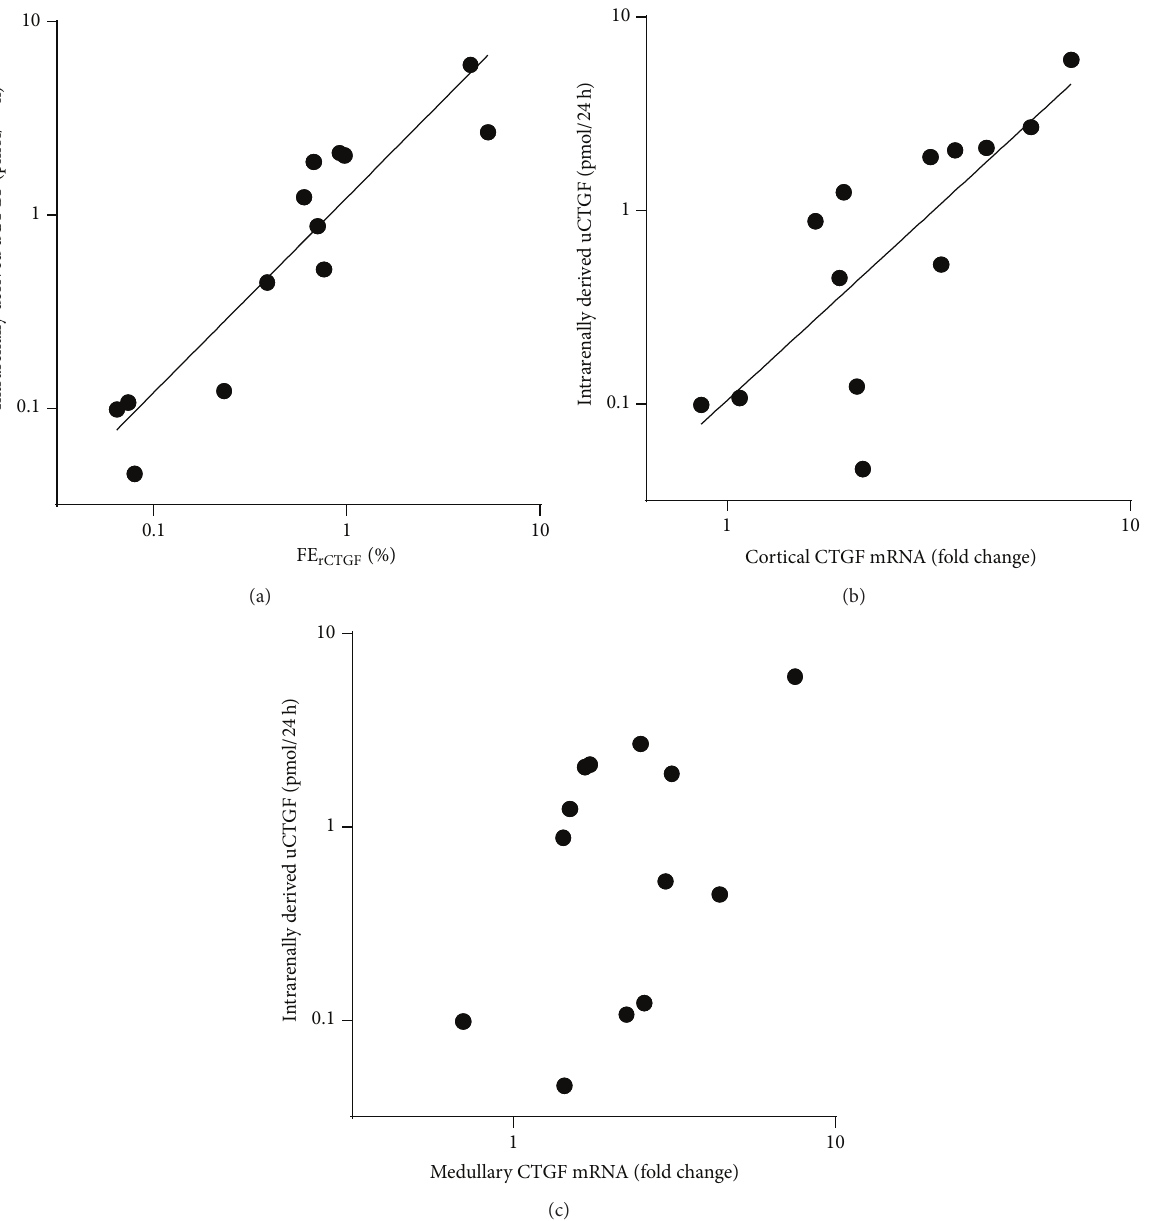
Figure 4: Urinary excretion of intrarenally produced CTGF correlates with the degree of tubular dysfunction. (a) Tight linear correlation between intrarenally derived uCTGF and FE rCTGF ( 𝑟 = 0.92 , 𝑃 < 0.0001 , slope = 1.0±0.1 ) suggests that tubular reabsorption failure is a major determinant of intrarenally derived uCTGF. (b) Cortical CTGF mRNA levels correlate with the intrarenally derived urinary CTGF (uCTGF), 𝑟 = 0.78 , 𝑃 = 0.002 . (c) Medullary CTGF expression does not correlate with intrarenally derived